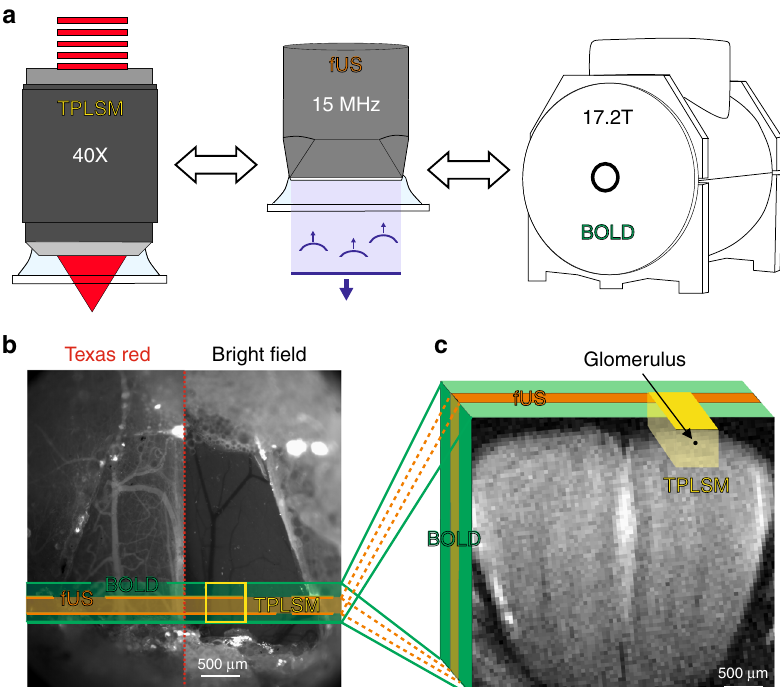
Fig. 1 A chronic mouse preparation compatible for imaging with TPLSM, fUS and BOLD-fMRI. a Experimental design: imaging the mouse brain with TPLSM, fUS and 17.2T BOLD-fMRI. b Dorsal view of a mouse olfactory bulb (OB) imaged through a chronic PMP window. Left side: wide- fi eld fl uorescence microscopy with super fi cial vessels labelled with Texas Red Dextran. Right side: bright- fi eld microscopy. The green stripe indicates the thickness (500 µ m) of a slice imaged with BOLD-fMRI. The orange stripe indicates the thickness of the slice (200 µ m) imaged with fUS. The yellow square indicates the fi eld of view (500 × 500 µ m) imaged with TPLSM in the same slice. c Schematic of the 3D volumes imaged with the three techniques and superimposed on